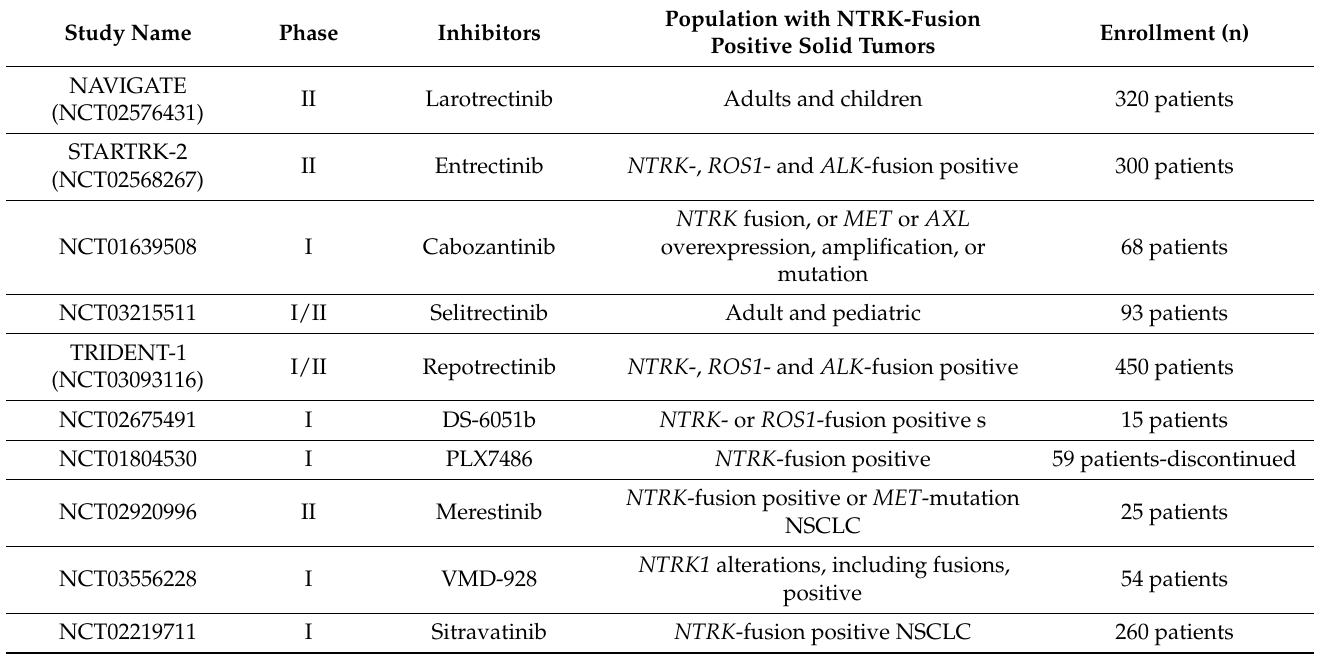
Table 4. TRK inhibitors clinical trials in NTRK fusion-positive solid tumors, including non-small cell lung cancer